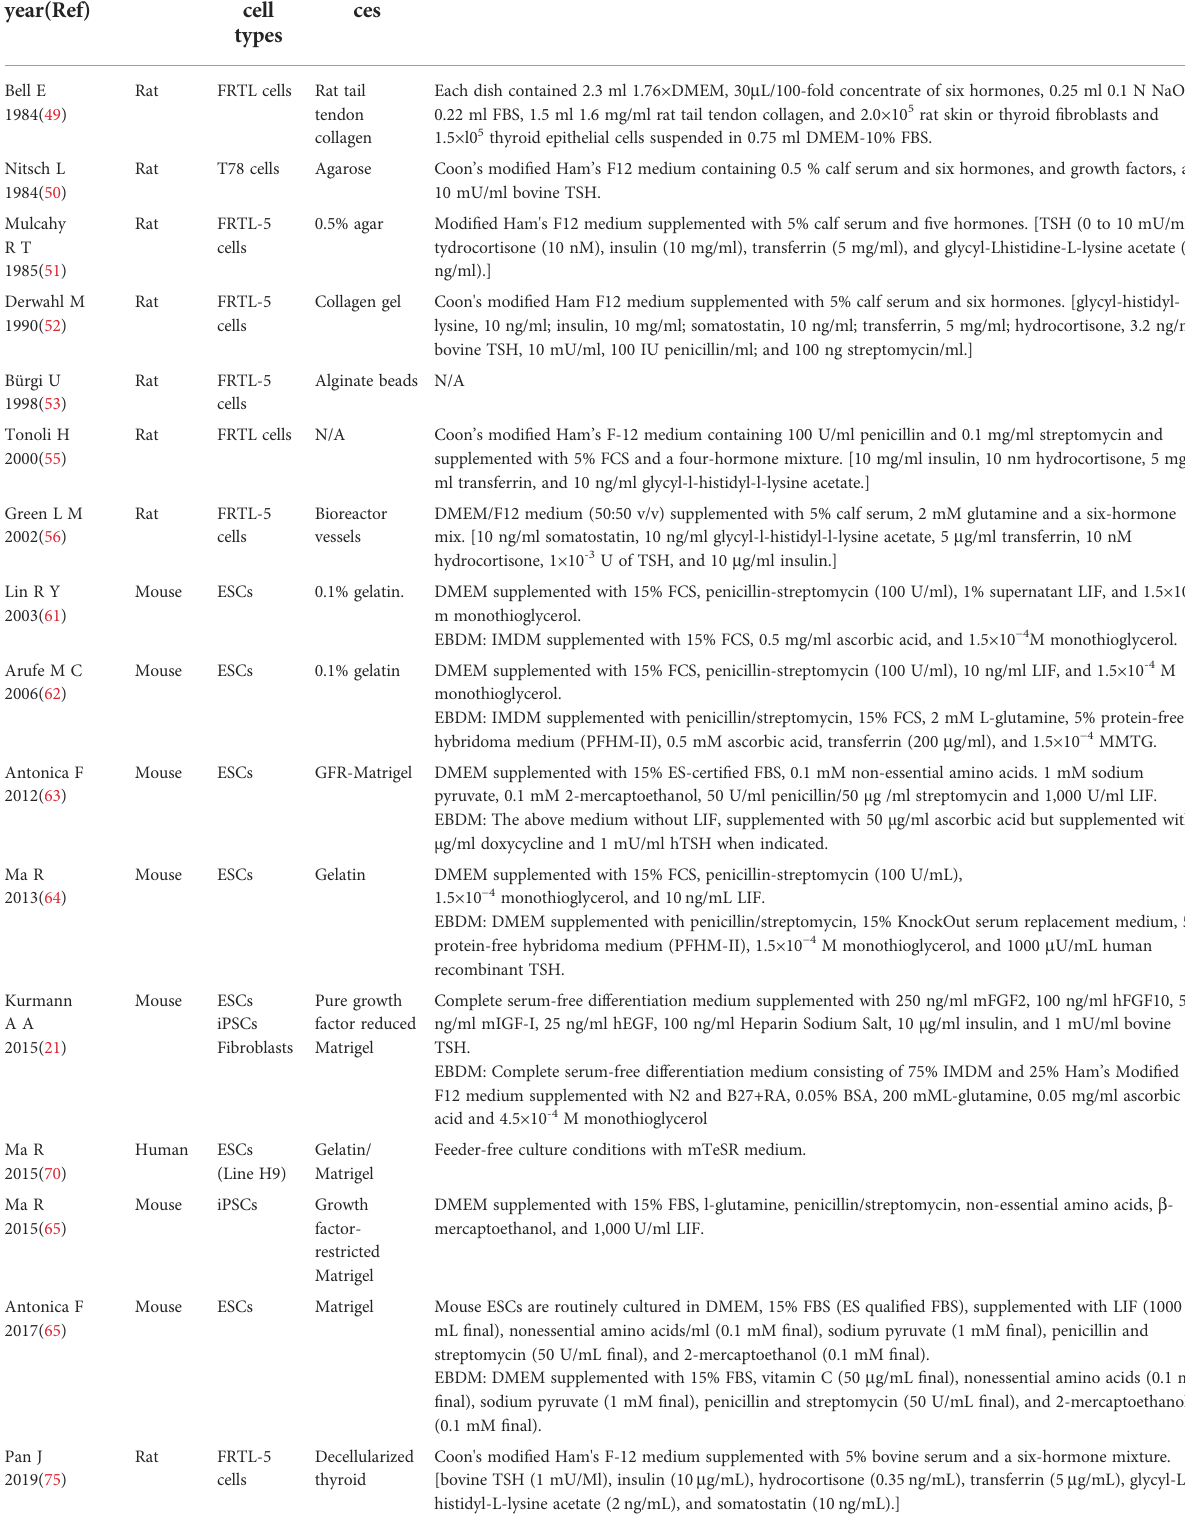
TABLE 1 Detailed 3D matrices and medium components for different thyroid cell types applied in